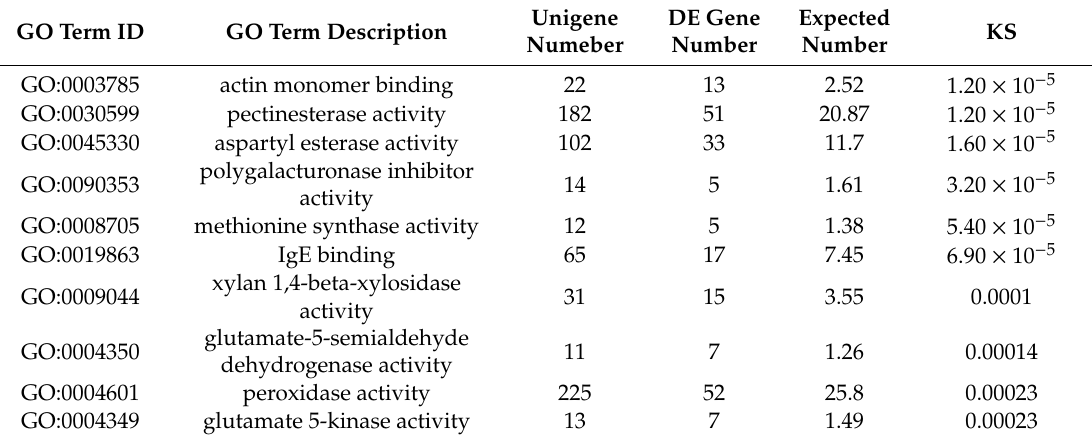
The “Unigene number” line, “DE Gene Number” line, “Expected Number” line, and “KS” line display the number of unigenes, number of di ff erentially expressed genes, expected number annotated to the related corresponding GO term, and the p -value of the KS test, respectively. Table 4. Top 10 GO terms in molecular function (MF) category of di ff erentially expressed genes in Bcpol97-05A (sterile line) compared to Bcajh97-01B (fertile line) of Brassica campestris .